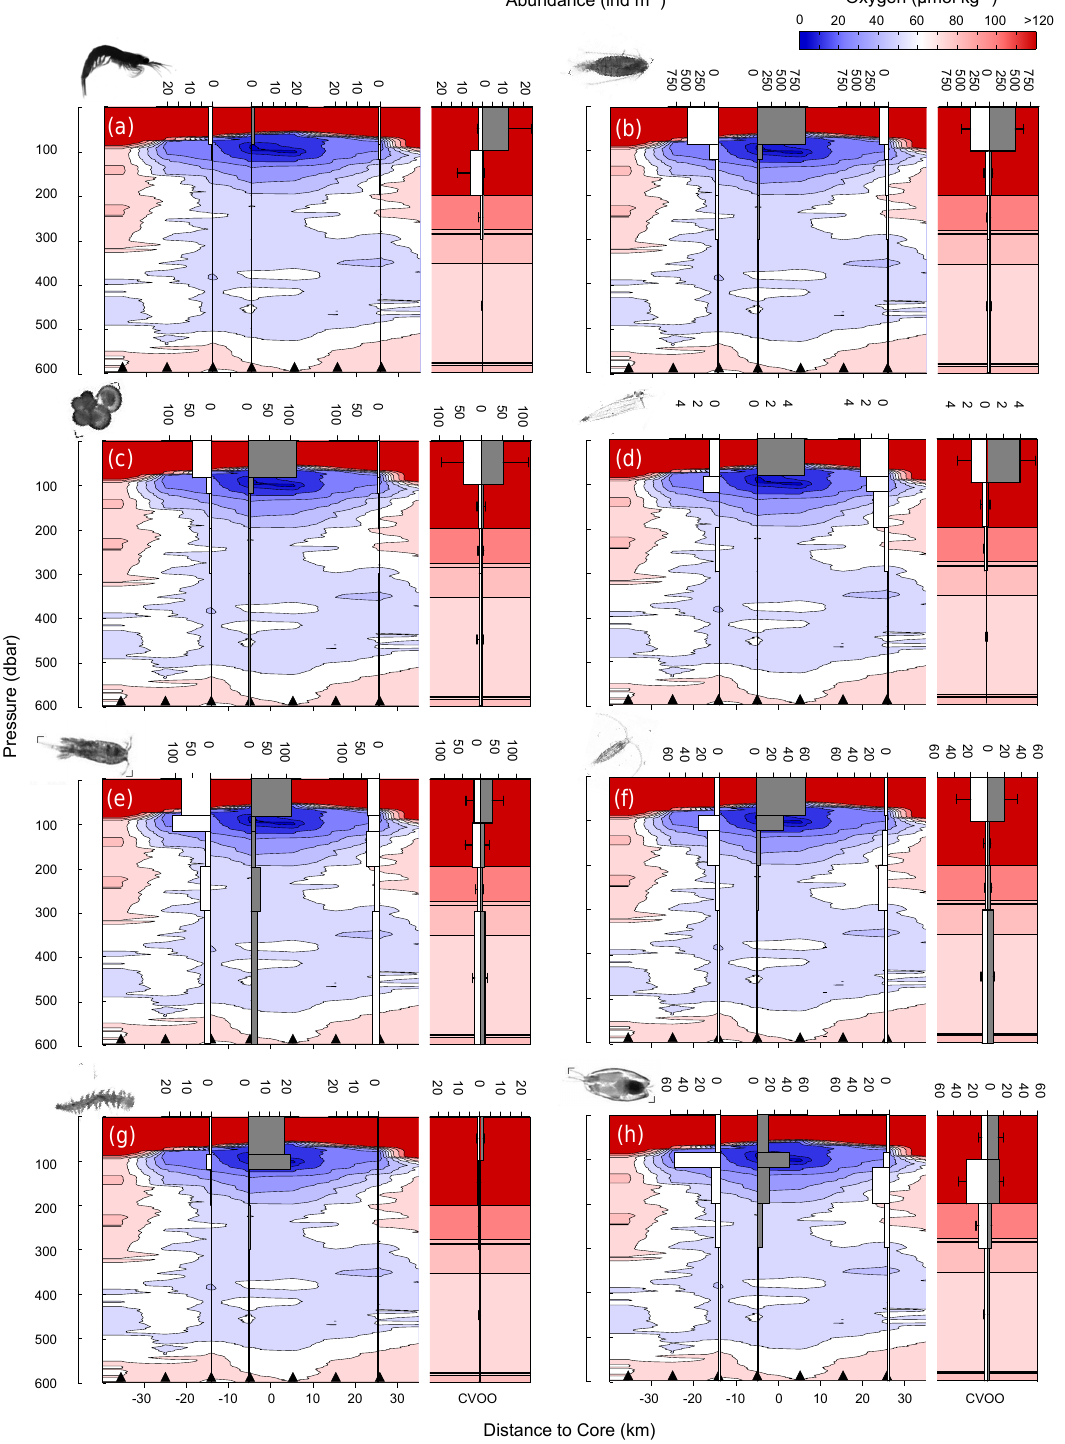
Figure 6. Oxygen contours (µmolO 2 kg − 1 ) across the eddy (from NE to SW) with superimposed bar plots of multinet-based abundance (individualsm − 3 ) of euphausiids (a) , calanoid copepods (b) , foraminifera (c) , siphonophores (d) , Oncaea sp. (e) , eucalanid copepods (f) , polychaetes (g) and ostracods (h) . White and grey bars indicate daylight and nighttime hauls, respectively. Triangles denote CTD stations used for the O 2 section. For the CVOO station (outside eddy situation), the mean ( + SD) of four D /N samplings is shown and the distance to core is not calculated because data were combined from different cruises. Representative images are shown next to the respective category